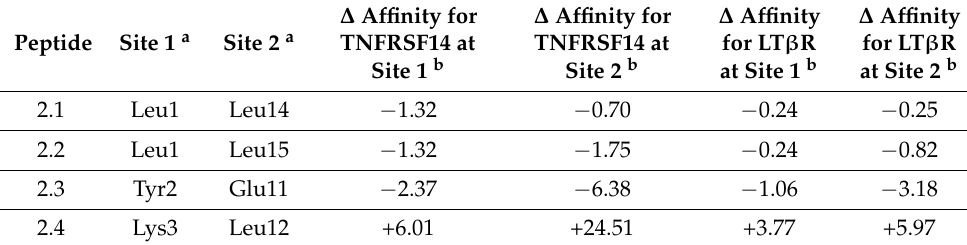
Table 2. Cysteine mutation